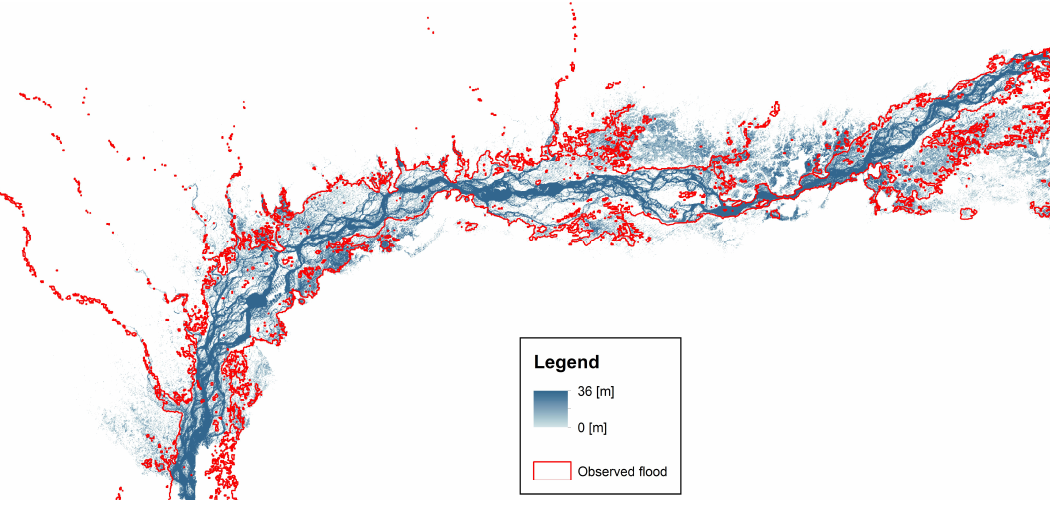
Figure 7. Simulated (using uncorrected TRMM) and satellite observed inundation map for the flood of 23 September